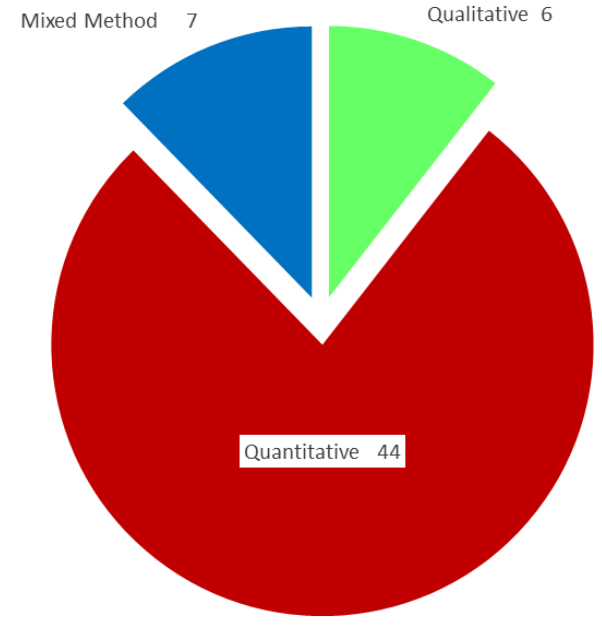
Figure 3. Articles included in the review by the applied method. Table 1. Most influential journals in the research area under study.